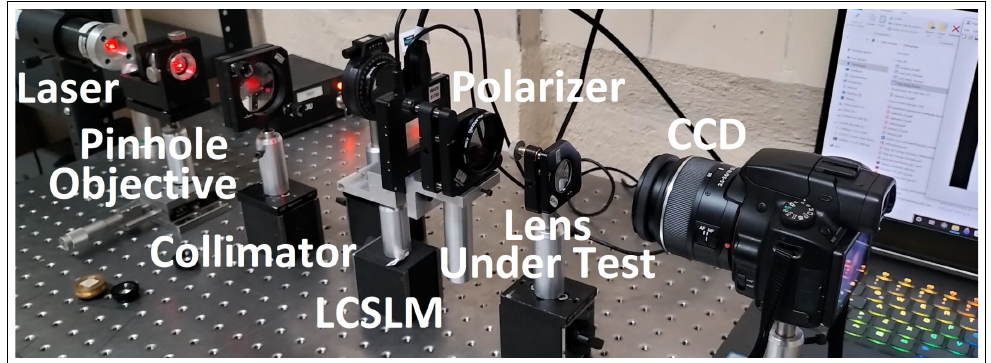
Figure 1. TIE simulation considering the laser illumination sources, pinhole objective, collimating lens (master), LCD (LC 2012 SLM, LCSLM) followed by a polarizer at 1 cm, the position of the object under test (L1, L2 and L3) and CCD. We replace the Ronchi ruling in the traditional TIE [23] with an LCSLM (along with a polarizer).